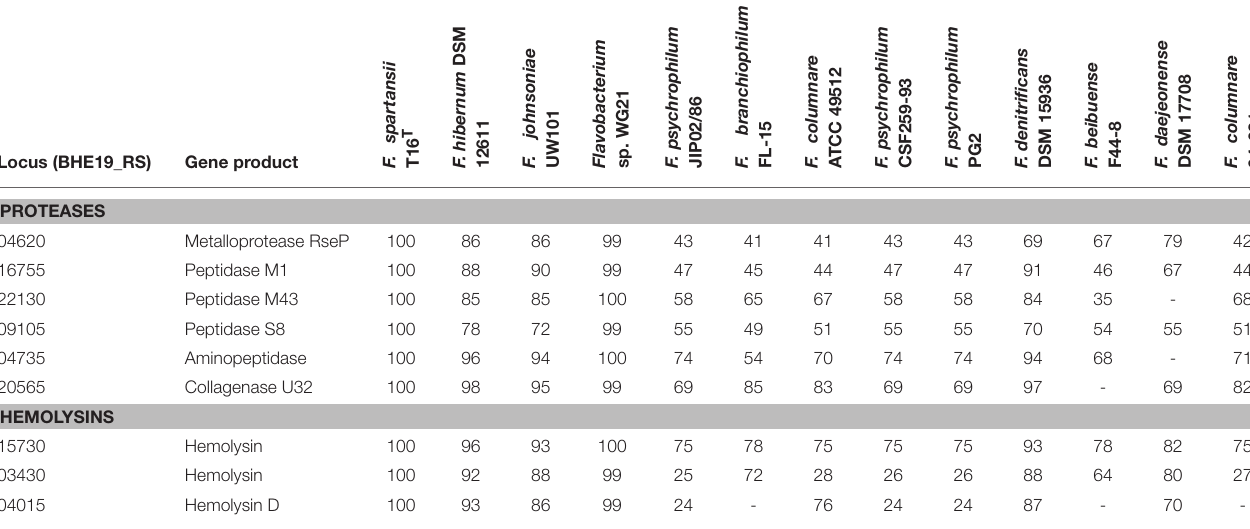
TABLE 5 | Proteases and hemolysins in Flavobacterium spp.*.